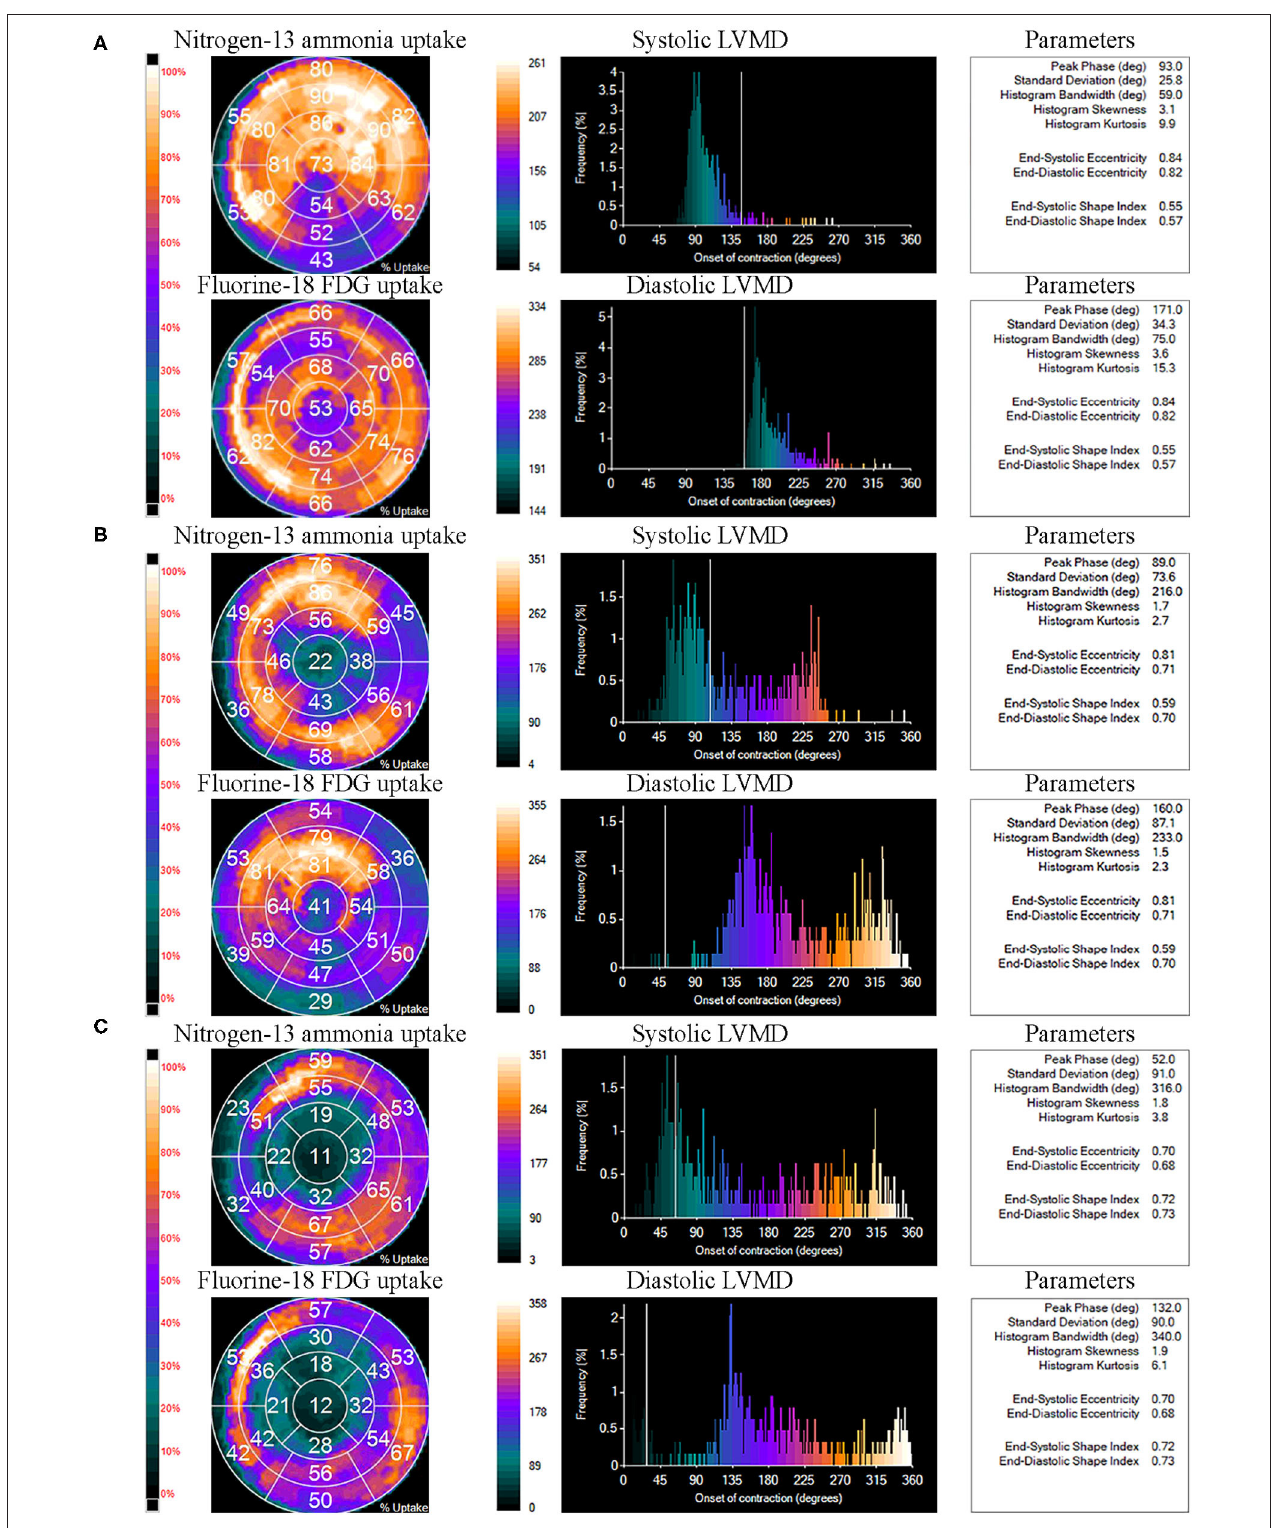
FIGURE 3 | Examples of left ventricular mechanical dyssynchrony (LVMD) analysis of Group 1 (A) , Group 2 (B) , and Group 3 (C) . The panels tagged “Nitrogen-13 ammonia uptake” and “Fluorine-18 FDG uptake” represent the percentage of Nitrogen-13 ammonia and Fluorine-18 FDG uptake by each myocardial segment on LV polar maps. The panels tagged “systolic LVMD” and “diastolic LVMD” are the phase histograms of systolic LVMD analysis and diastolic LVMD analysis, respectively. Relative LVMD parameters were also output on the right.